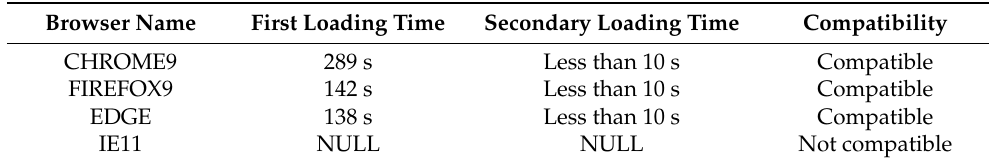
Table 5. Performance test results of different browsers.